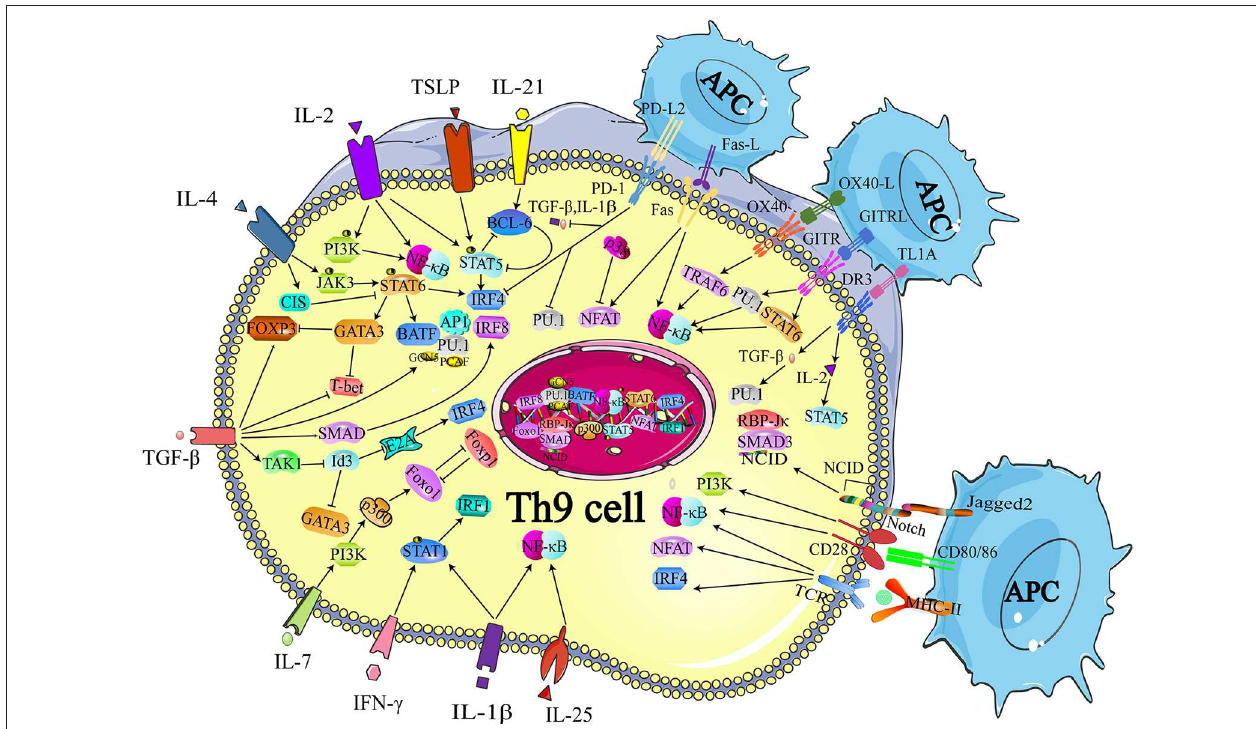
FIGURE 1 | Transcriptional regulation of Th9 cell differentiation. The development of Th9 cells mainly relies on TCR-NFAT/NF- κ B signals, IL-2-STAT5 signals, TGF- β -SMAD signals, and IL-4-STAT6 signals. Some other cytokines are also identified to synergistically enhance Th9 cell development, such as IL-1, IL-25, IL-7, IL-21, while IFN- γ is reported to inhibit IL-9 production through STAT-1. These signals also induce expression of the GATA3, IRF 4, IRF8, IRF1, PU.1, and BATF, which contribute to the chromatin modification at IL-9 and IL-21 locus. Many proteins or small molecules are reported to activate the NFAT and NF- κ B, such as OX40, GITR, and TL1A. TCR, T cell receptor; NFAT, nuclear factor of activated T cells; NF- κ B, nuclear factor- κ B; STAT, Signal Transducer and Activator of Transcription; TGF- β , transforming growth factor- β ; GATA-3, GATA-binding protein 3; IRF, transcription factors interferon (IFN)-regulatory factor; BATF, basic leucine zipper transcription factor, ATF like; NICD, Notch intracellular domain, RBP-Jk, recombination signal binding protein for immune globulin kJ region; OX40, Tumor necrosis factor receptor superfamily member 4; GITR, glucocorticoid-induced tumor necrosis factor receptor (TNFR)-related protein; OX40, Tumor necrosis factor receptor superfamily member 4. Figures were produced using Servier Medical Art